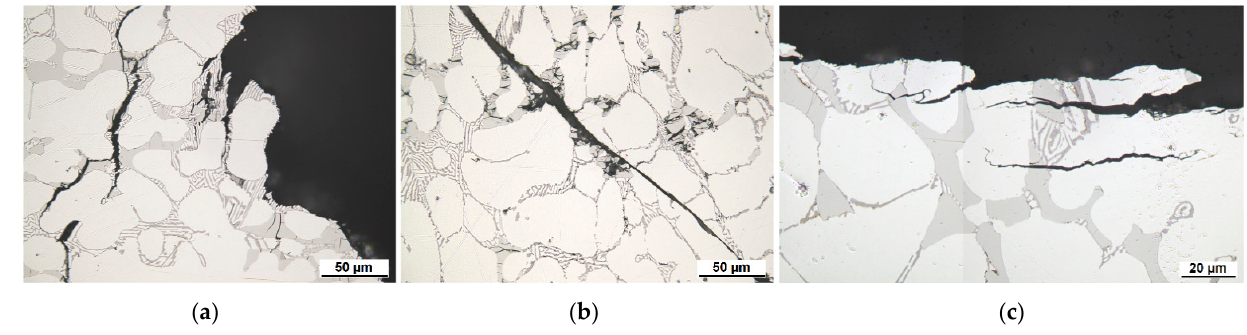
Figure 3. Cross-sectional micrographs of fracture surfaces after tensile load ( a ), compression load ( b ) and fatigue load ( c ) showing the crack propagation of the sub-cracks near the main crack and its interaction with the microstructural features.